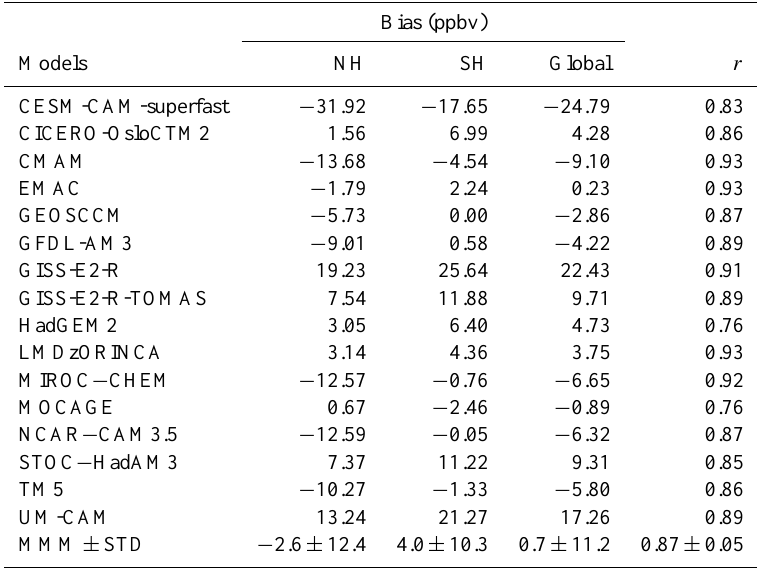
Table 3. Model versus MOPITT CO annual mean bias for the Northern Hemisphere (NH), Southern Hemisphere (SH), and Global at 500hPa. Annual mean spatial pattern correlation coefficients ( r ) between model and MOPITT CO global retrievals are in the right-most column.